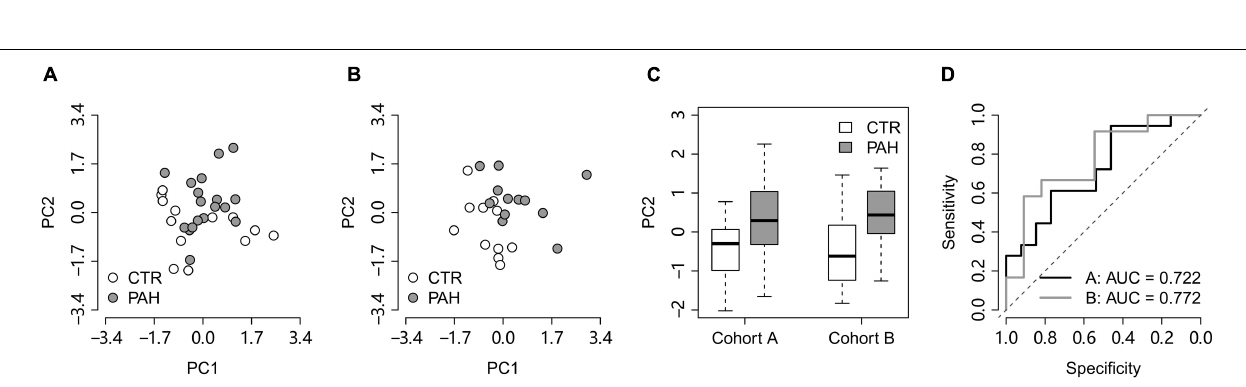
FIGURE 2 | The HIF2 α -mediated GO terms distinguish PAH patients from controls in the lung validation data sets. (A,B) Principal component analysis on the HIF2 α -mediated GO terms in the validation cohorts (A,B) , respectively. PC1 and PC2 represent the first principal component and the second principal component, respectively. (C) PC2 differentiates the PAH patients from the controls in the validation cohorts. (D) The ROC curves of PC2 in distinguishing PAH patients from controls in the validation cohorts. CTR, control; PAH, pulmonary arterial hypertension.